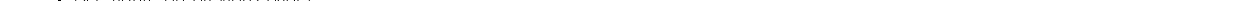
(shScrambled) (Fig. 4b, left). This was con fi rmed by densitometry (Fig. 4b, right). We also analyzed the protein levels of MNT and NF- ĸ B proteins after MNT knock- down. The results showed an increase in p65 and a